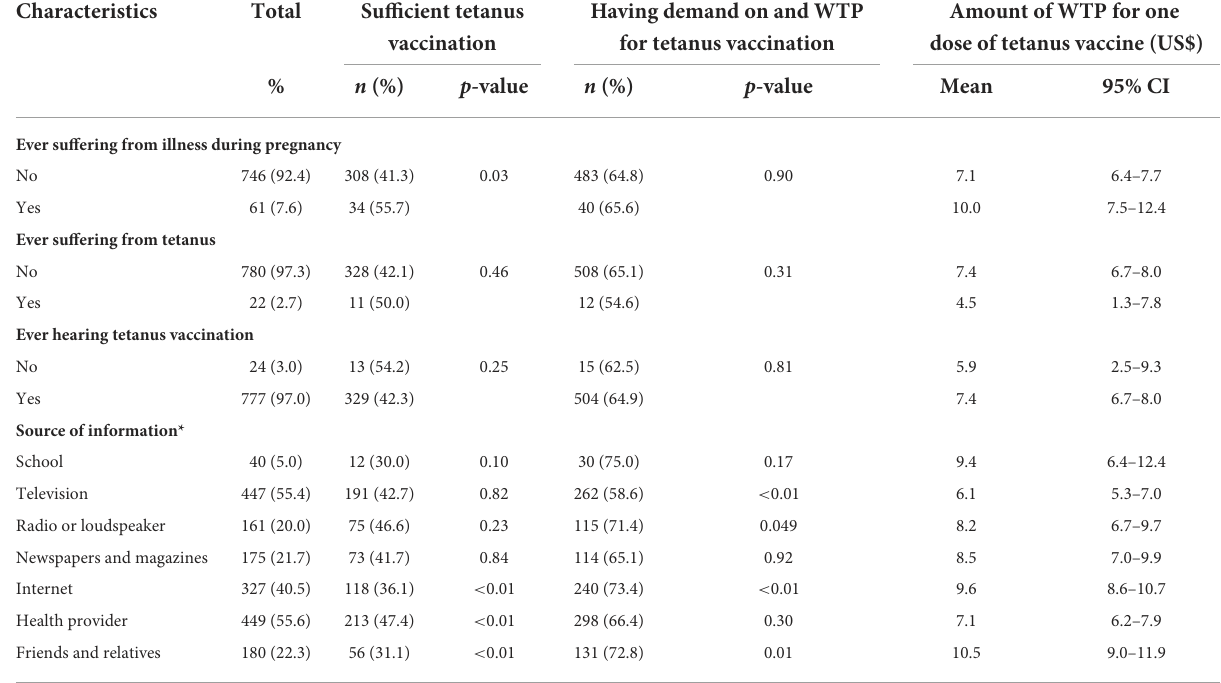
TABLE 2 Tetanus vaccination uptake, demand, and WTP by the history of tetanus and source of tetanus vaccination information. Characteristics Total Sufficient tetanus Having demand on and WTP Amount of WTP for one vaccination for tetanus vaccination dose of tetanus vaccine